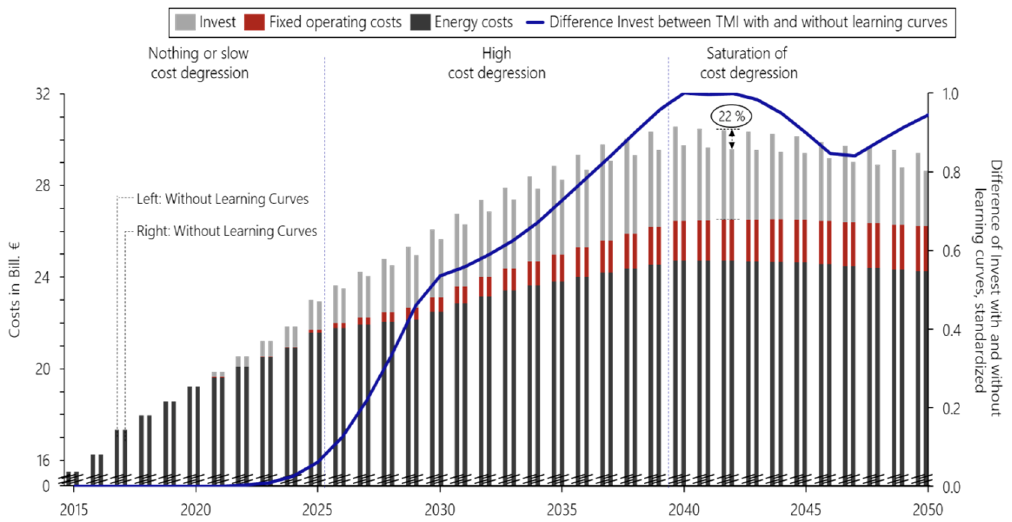
Figure 12. Cost of the TMI scenario without (left bar) and with (right bar) learning curves differentiated according to investment, fixed operating and energy costs, additionally standardised difference between investment with and without learning curves (purple line).